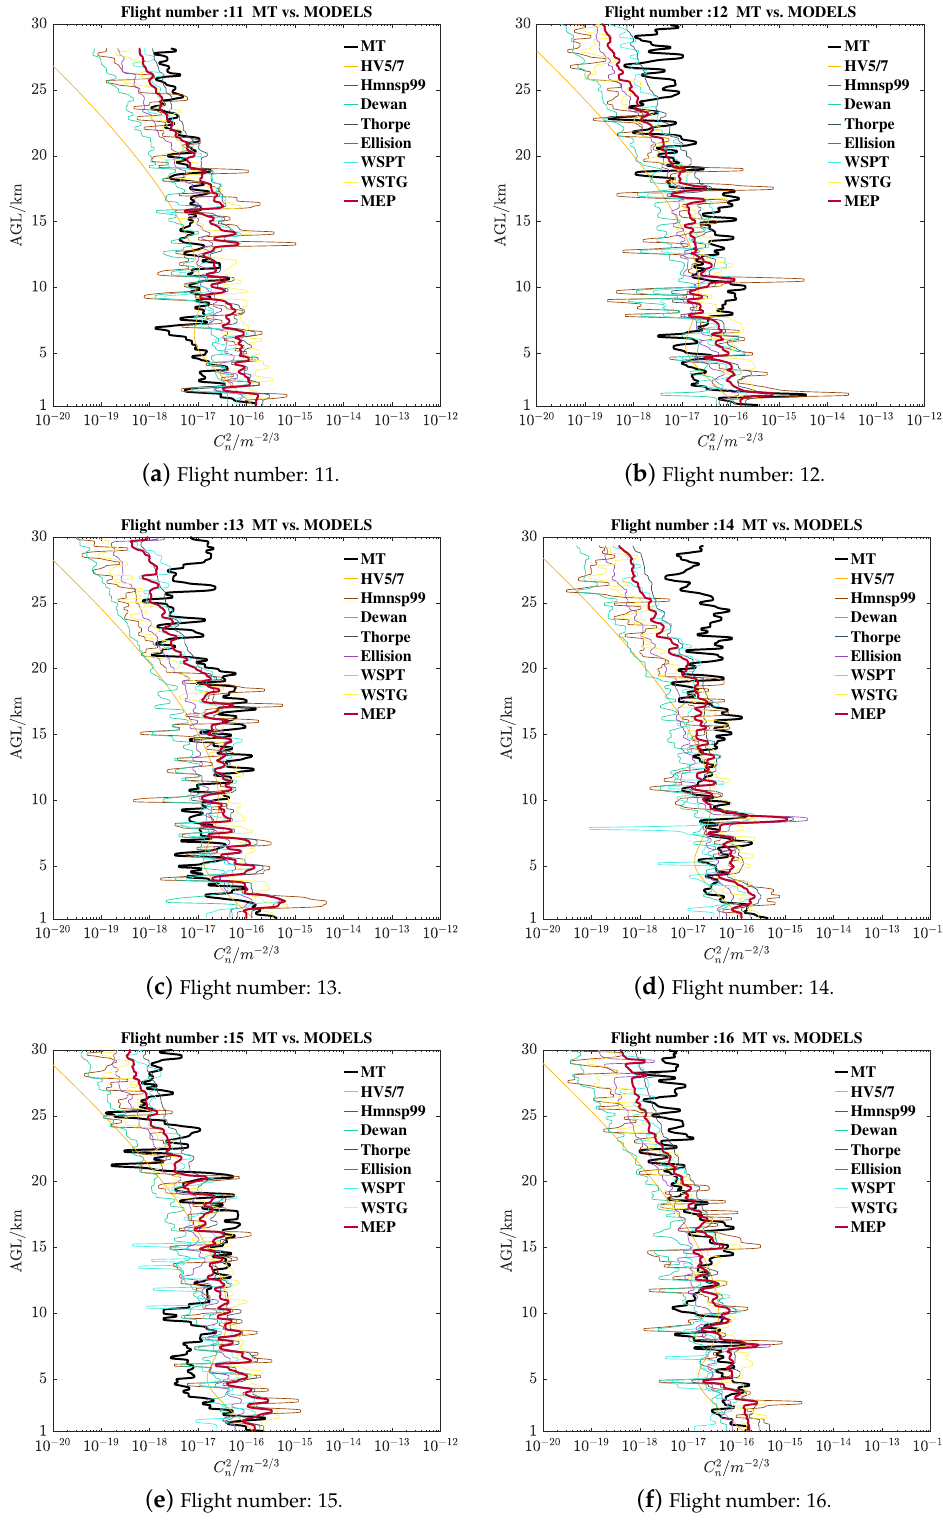
Figure A3. The refractive index structure parameter profiles of MT and estimations in ECACN: Figure A3 sub-figures ( a – f ) are flight numbers 11–16 in Table